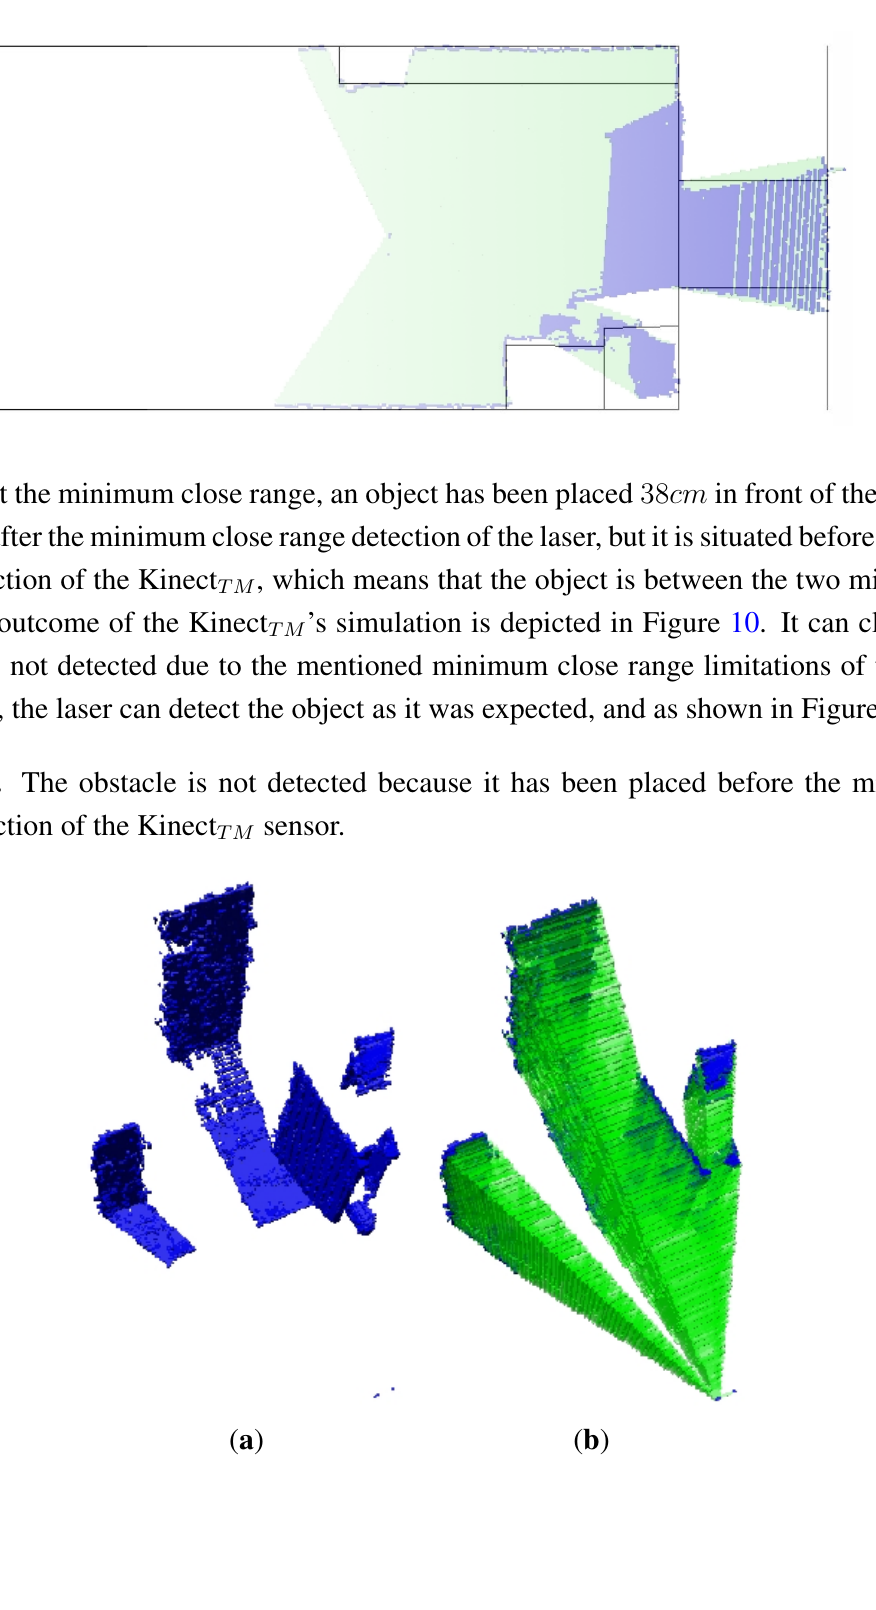
Figure 9. The two fused data sets are compared with the true